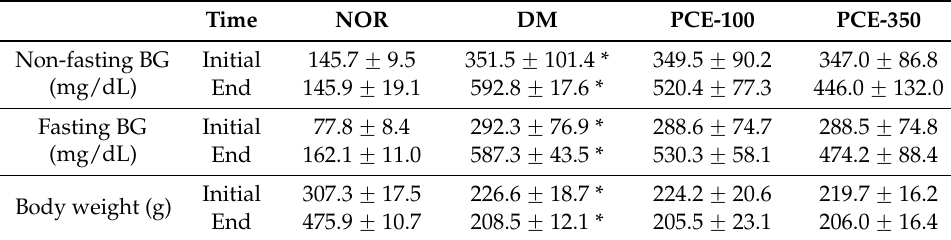
Table 1. Blood glucose levels and body weight.